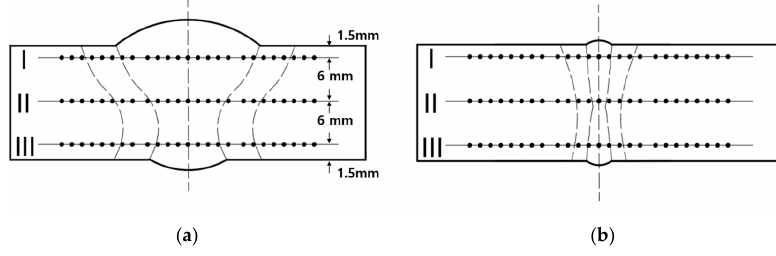
Figure 7. Measurement points of hardness test. ( a ) FCAW; ( b ) LBW.